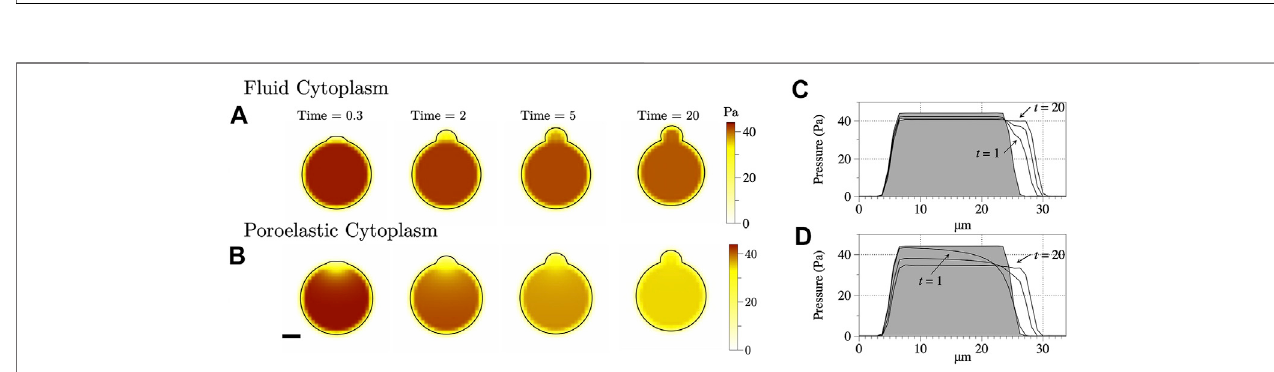
FIGURE 3 | A bleb is initiated by a loss of membrane-cortex adhesion within the bleb ring region using (A) a pure fl uid cytoplasm and (B) a poroelastic cytoplasm. The colorbar indicates the speed of the cell membrane in μ m/s. The white ring at the top of the cell at 0.3 s indicates the initial location of the bleb ring. The red curve indicates the xz -plane that intersects the cell membrane to generate 2D slices of the pressure fi eld. The red point in (A) is used to de fi ne bleb height.